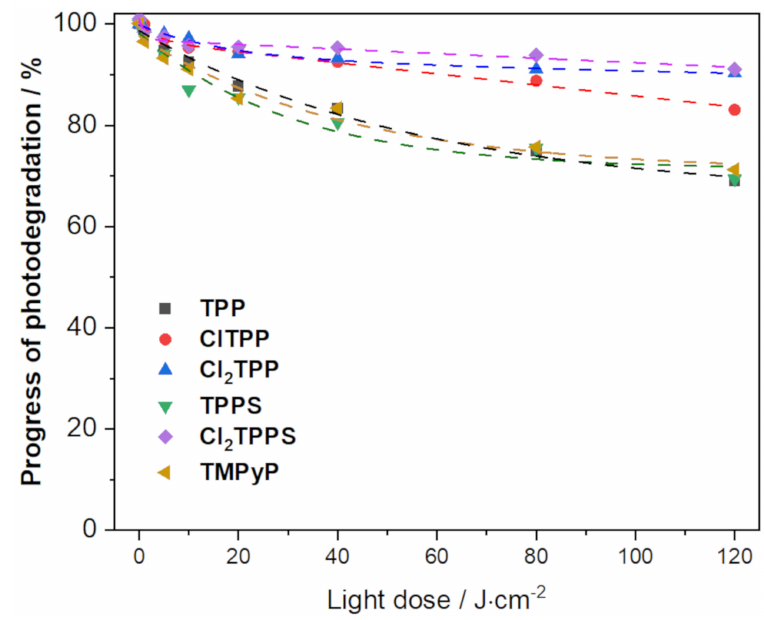
Figure 9. The photostability of porphyrins: TPP, ClTPP, Cl 2 TPP, TPPS, Cl 2 TPPS, and TMPyP in PBS solution (DMSO content < 1%) with an absorbance ca. 1. Irradiation of the porphyrin solution was carried out using a 420 nm LED with various light